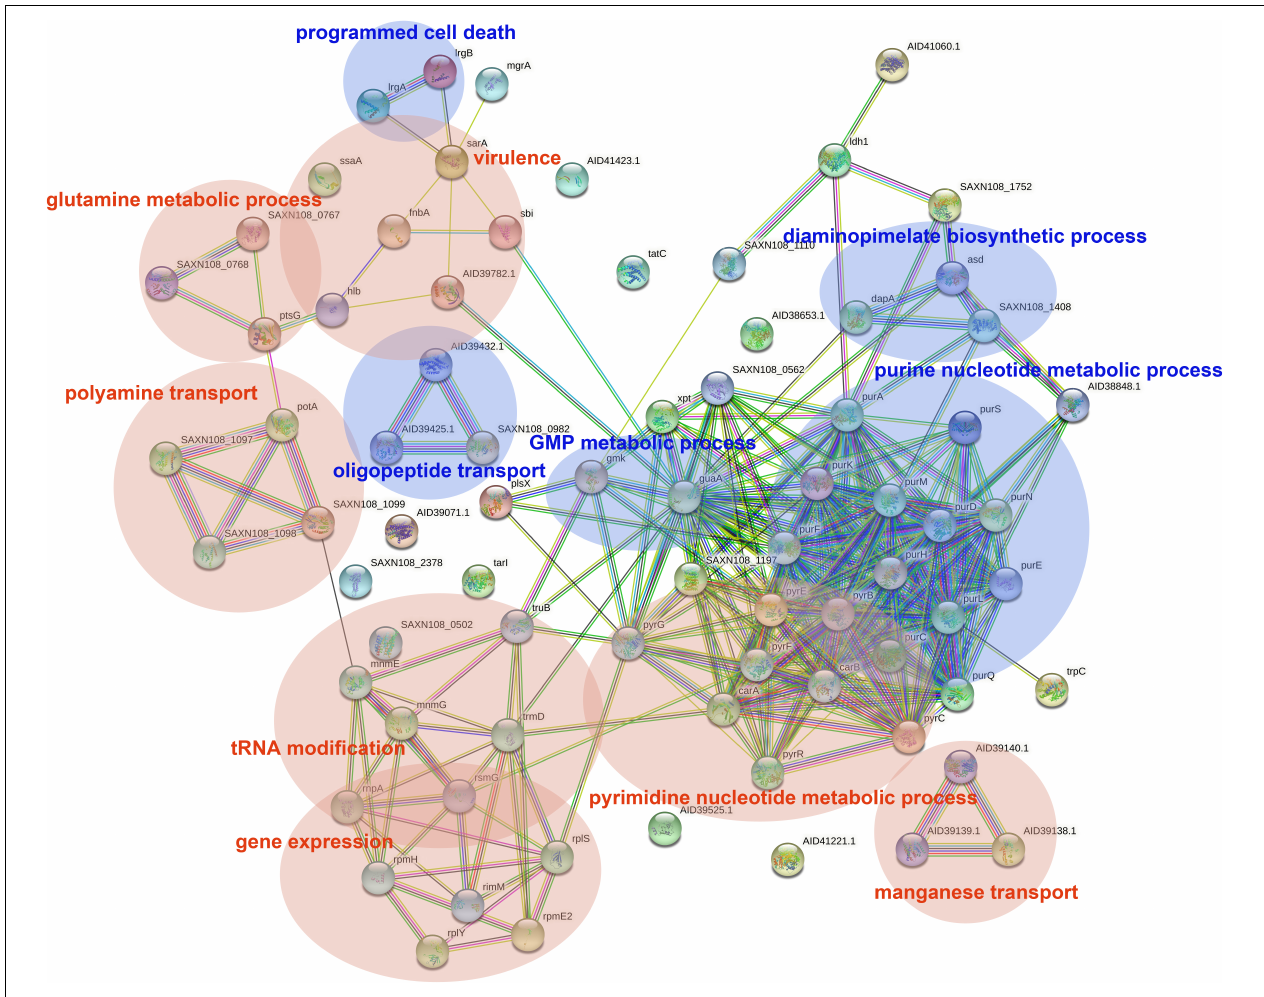
FIGURE 5 | PPI network of DEGs in logarithmic phase. PPI, protein–protein interaction. Circles represent genes, lines represent protein interactions, and protein structures are shown in circles. Line color represents evidence of the interaction between the